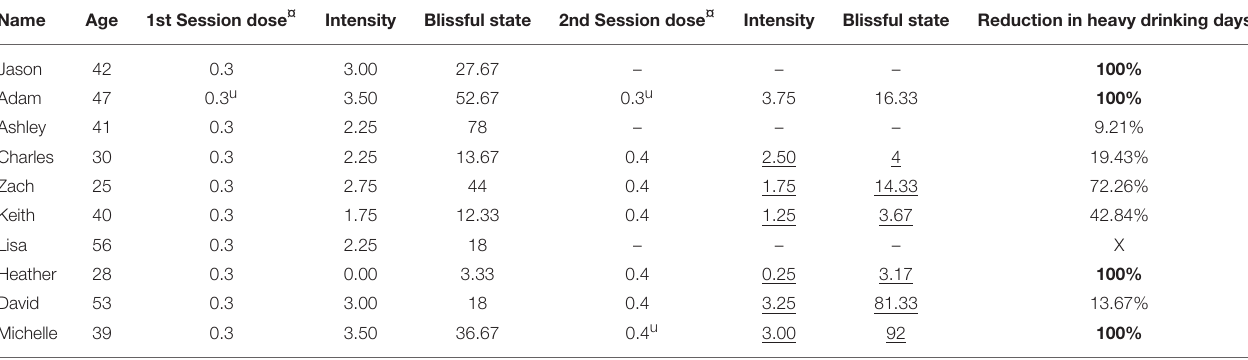
TABLE 1 | Participant demographics, intensity, and blissful state